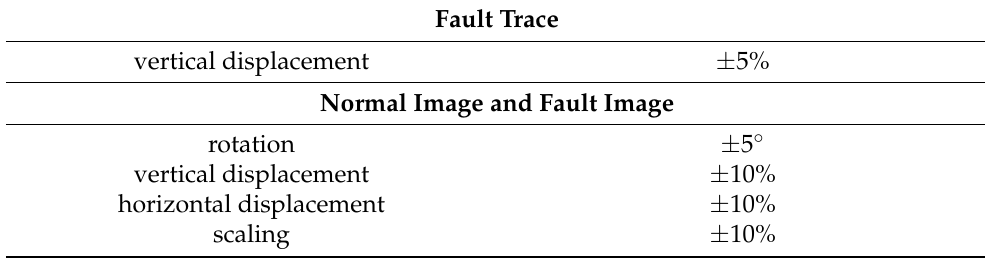
Table 1. The Data Augmentation